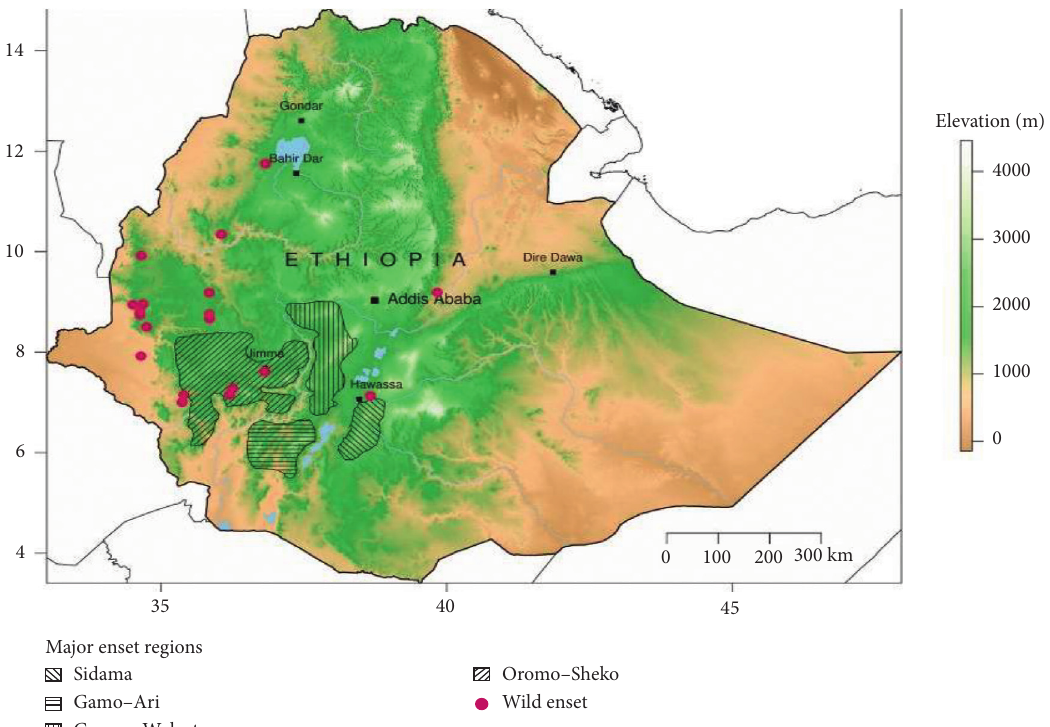
Figure 1: Distribution of major domesticated enset-growing regions, also called Enset belt areas (shaded polygon) and wild enset records (red points) in Ethiopia (Source: